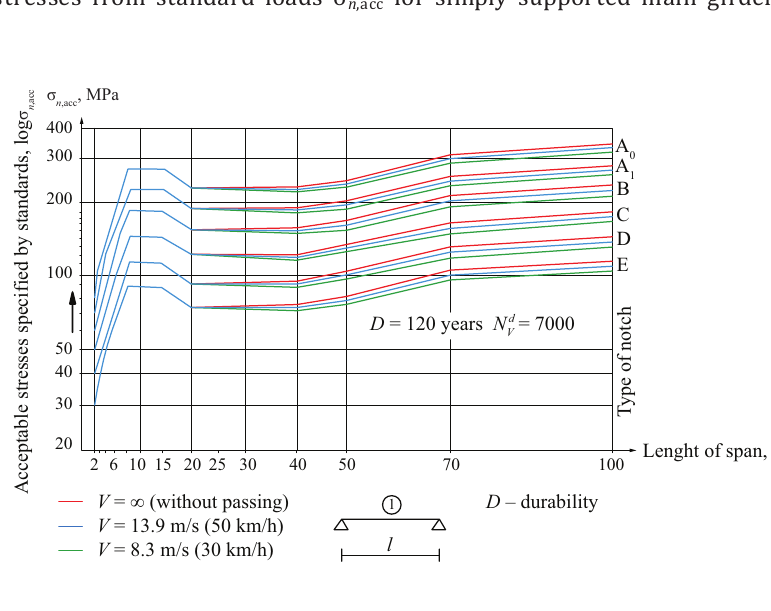
Figure 12. Graphs of values of permissible strains from standard loads